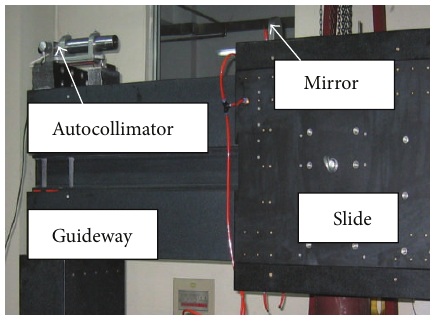
Figure 5: Experimental setup for measurement straightness of cross guideway.